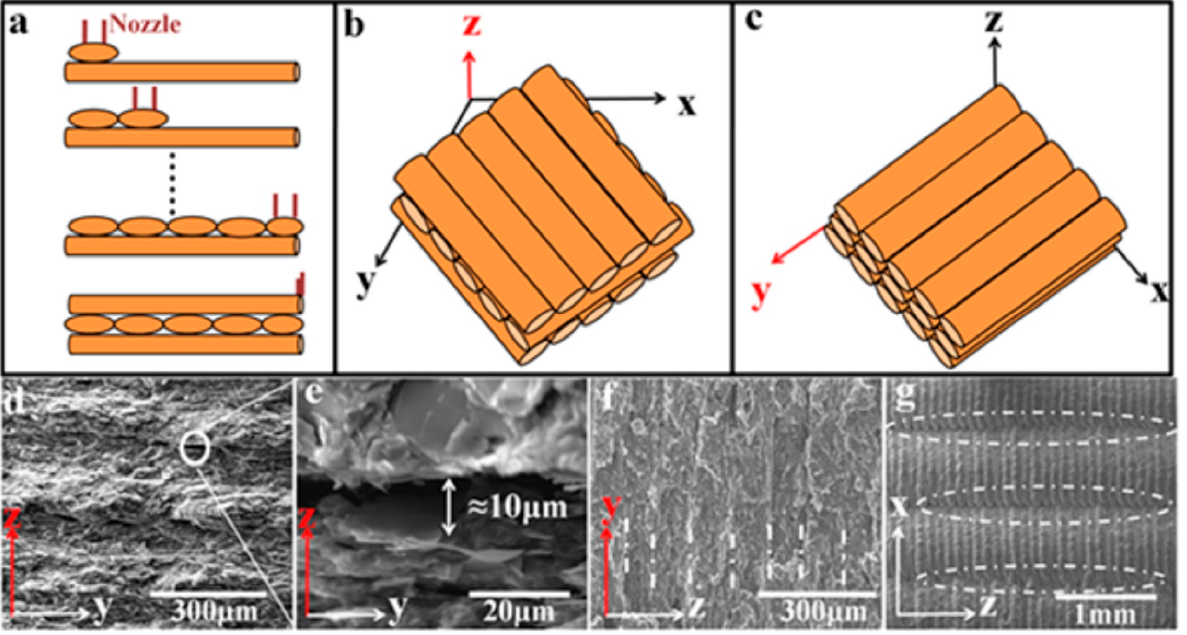
Figure 15. ( a ) Schematic illustration of void generation during FFF; ( b , c ) schematic illustration of void formation in FP and SP; ( d – f ) the voids of FP ( d , e ) and SP with the same filler content ( f , g ) (reproduced with permission from Reference [63], Copyright 2017 Elsevier).